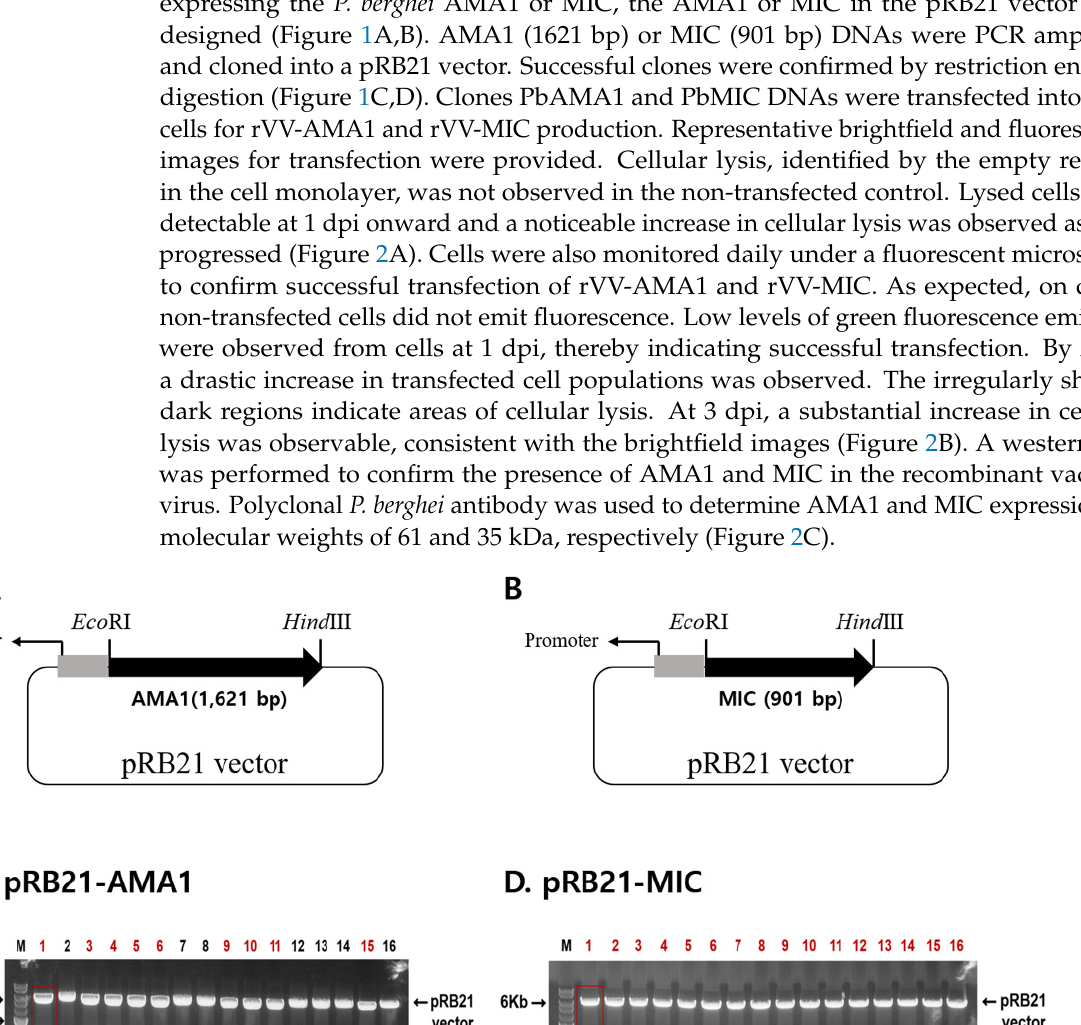
Figure 2. Transfection of CV-1 and confirming the production of rVV. The pRB21-PbAMA1 and pRB21-PbMIC DNA constructs were transfected into CV-1 cells, along with the vaccinia virus, to generate rVV-AMA1 and rVV-MIC. Representative images of rVV transfection under brightfield ( A ) and fluorescent microscope ( B ) are illustrated over the course of 3 days. AMA1 and MIC rVVs were identified by a Western blot using a P. berghei polyclonal antibody and a wild-type vaccinia virus (wt VV) control ( C ). 3.2. IgG Antibody Responses A schematic diagram depicting immunization and challenge infection schedules was provided (Figure A2). Sera were regularly collected from mice 4 weeks after prime, 1st boost, and 2nd boost immunizations to assess parasite-specific IgG antibody responses against P. berghei antigen. Differences in antibody responses elicited by the two vaccines